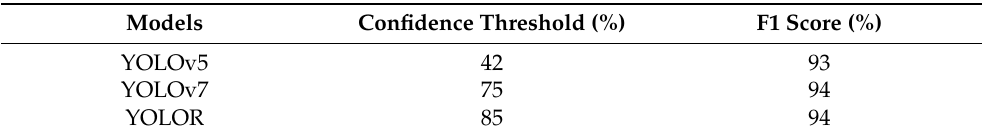
Table 6. Confidence threshold that optimizes the F1-score for each YOLO model with Grapevine Bunch Detection Dataset.